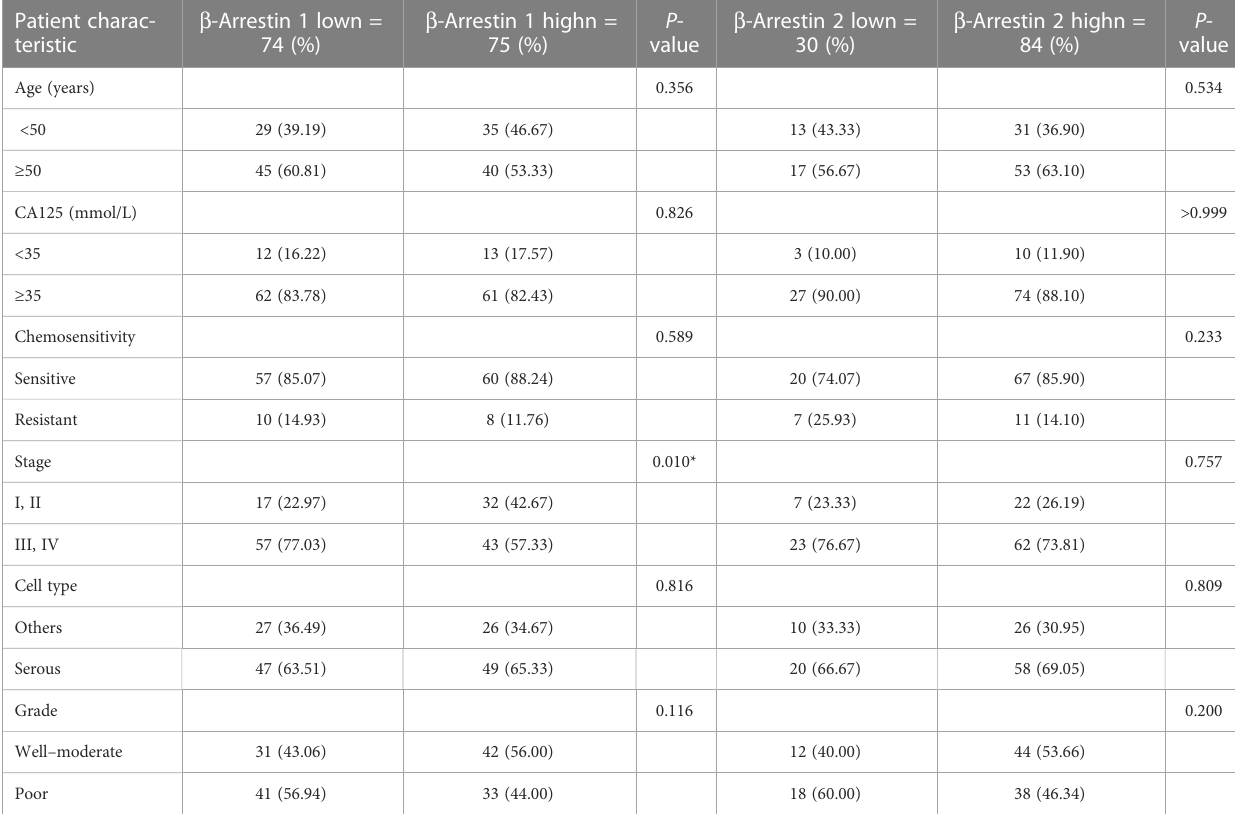
A. The association between clinicopathologic features and b -arrestin 1,2